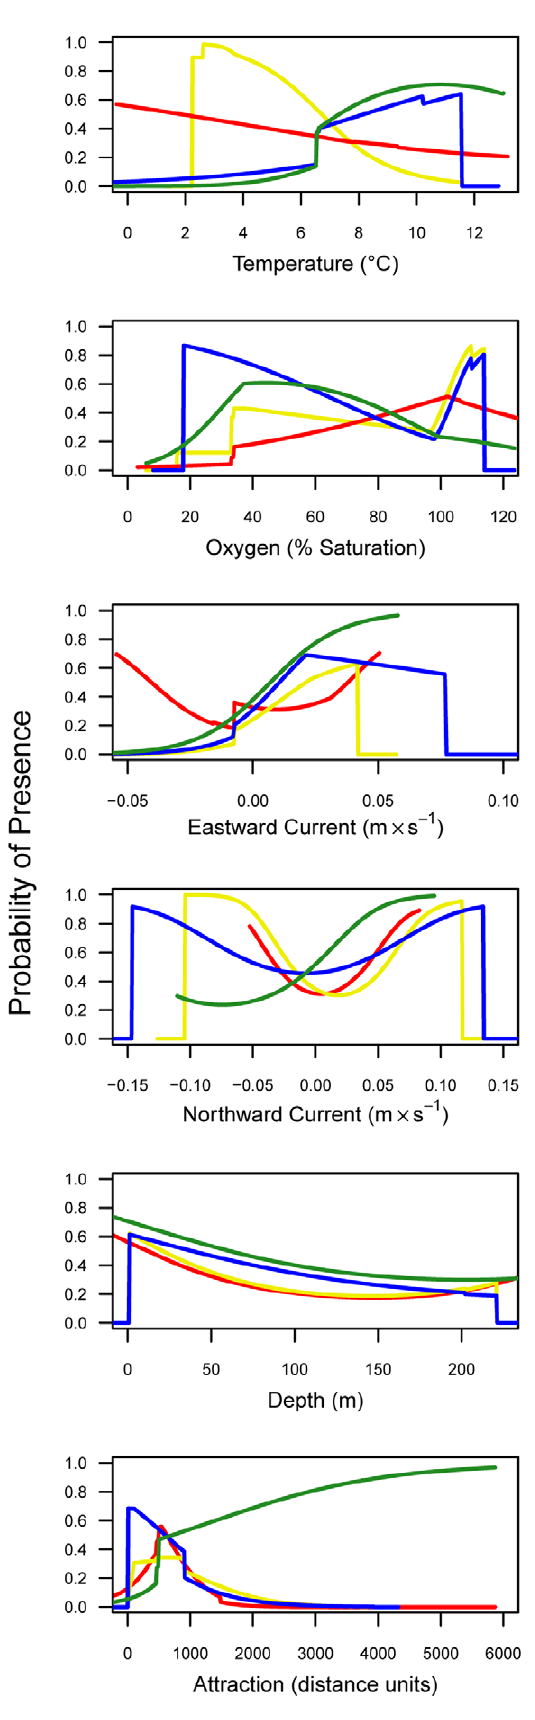
Figure 2. Response curves. Plots depict the seasonal (red=summer, yellow=autumn, blue=winter, green=spring) marginal response of green sturgeon to each of the six model covariates while keeping all other environmental covariates at their average sample values. The axes indicate logistic output (i.e. probability of presence from 0 to 1). For the attraction covariates, the distance between spawning and overwinter- ing grounds is equal to about 5000 cost units. Overwintering attraction is used in the autumn and winter when zero represents the overwintering location and spawning attraction, used in the summer and spring, indicates the mean location of the three spawning river